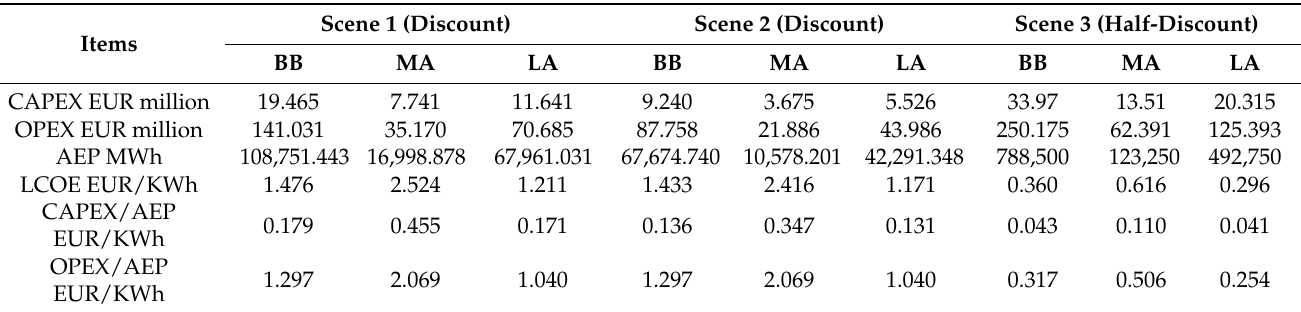
Table 9. Key results in the